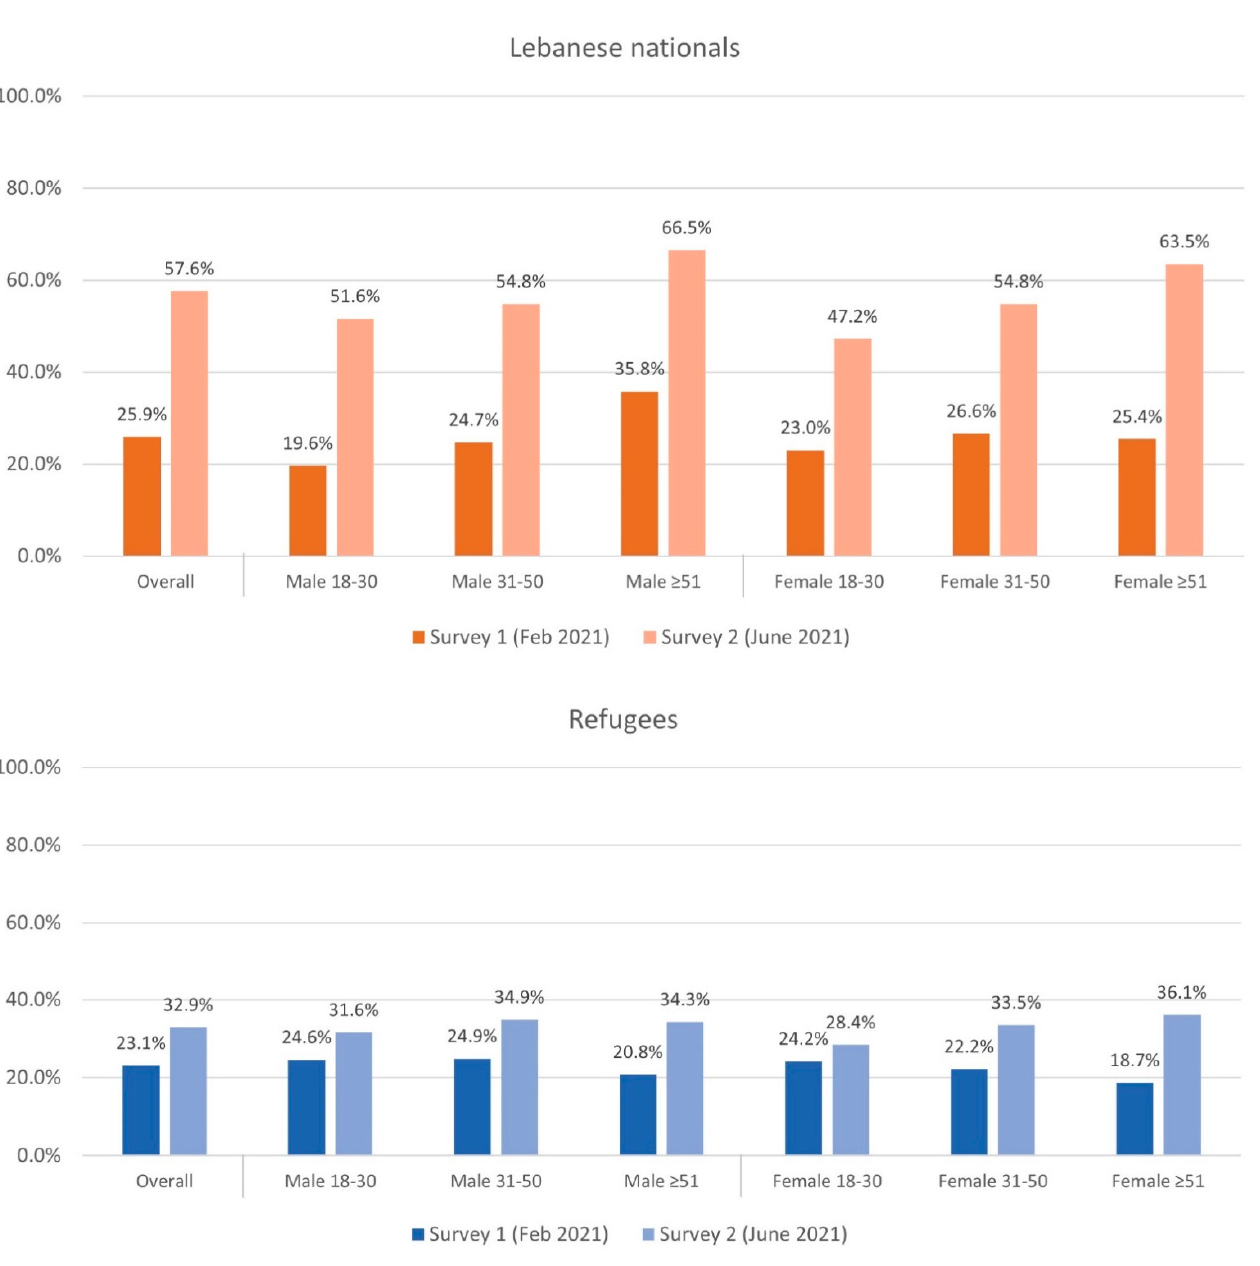
Figure 1. Vaccine intention among Lebanese nationals and refugee participants grouped by age category and gender in Survey 1 and Survey 2.